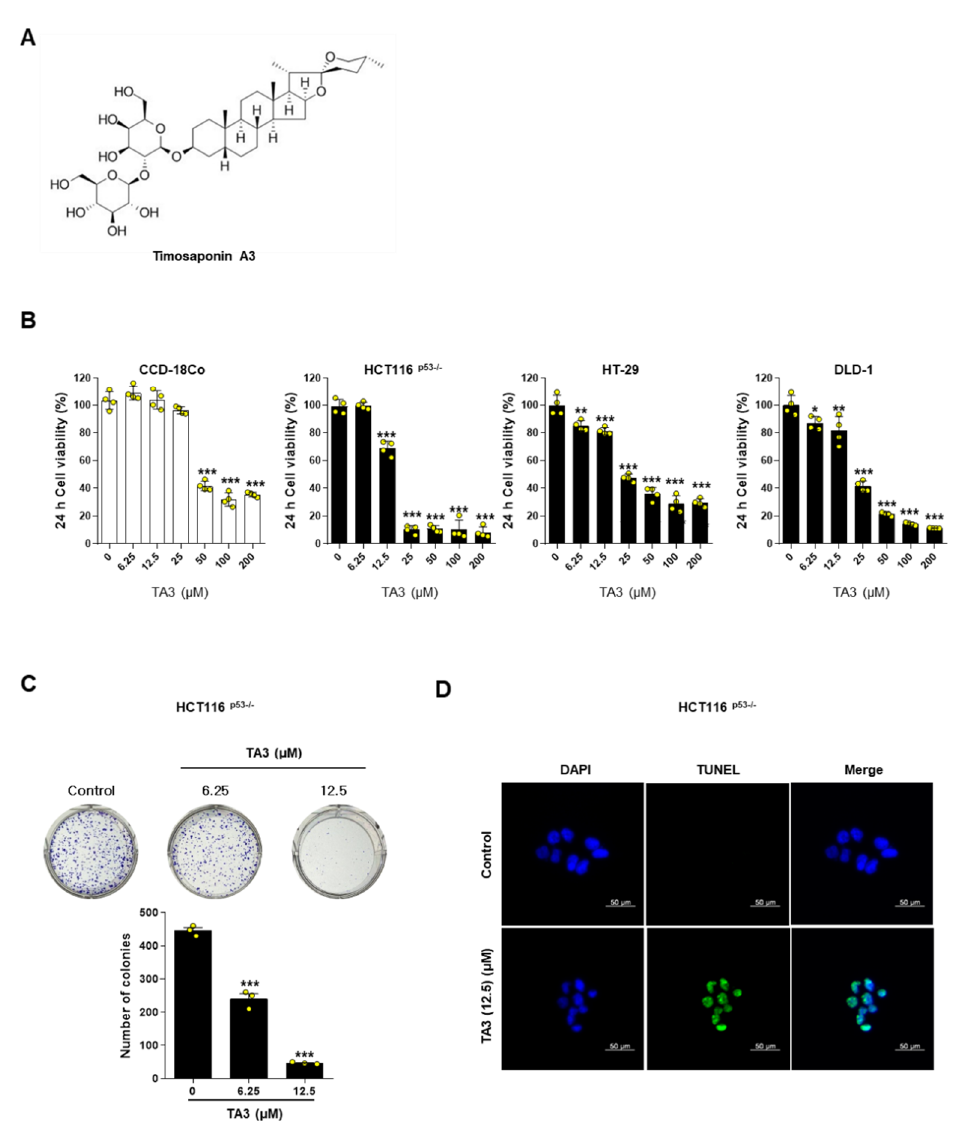
Figure 1. Timosaponin A3 (TA3) inhibits colon cancer cell viability and proliferation and induces apoptosis. ( A ) Chemical structure. ( B ) Effect of TA3 on cell viability in normal colonic cell line CCD- 18Co and colorectal cancer cell line HCT116 p53−/− , HT-29, and DLD-1 cells. Cells were treated with 0, 6.25, 12.5, 25, 50, 100, and 200 μM of TA3 for 24 h. After this, cell viability was evaluated by MTT assay with three independent experiments in each cell. ( C ) Colony formation photos (upper figure) and bar graph (below figure) in HCT116 p53−/− cells. Cells were treated with 0, 6.25, and 12.5 μM of TA3 for 24 h. HCT116 p53−/− cells were treated with TA3 for 24 h and then the new medium was changed for 10 days (every 2–3 days, the new medium was changed). After 10 days, cells were stained with Diff Quick solution 2. Then, cells were dried and counted. Statistical significance was analyzed using one-way analysis of variance (ANOVA) followed by Tukey’s test. p -value indicates a significant difference between the groups. Quantification of colonies is shown in the lower panel. * p < 0.01, ** p < 0.005, *** p < 0.001 vs. control. ( D ) HCT116 p53/− cell lines treated with TA3 were evaluated for apoptosis activity by TUNEL assay. Images are magnification 400 ×, scale bar 50 μm.